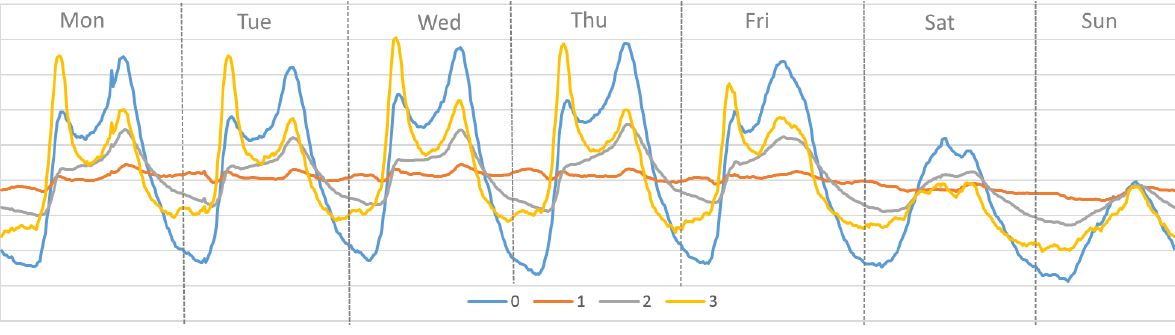
Figure 2. The resulting traffic load profile prototypes’ mean week starting on Monday. They differ with regard to their amplitude, their shape and the number of their peaks.